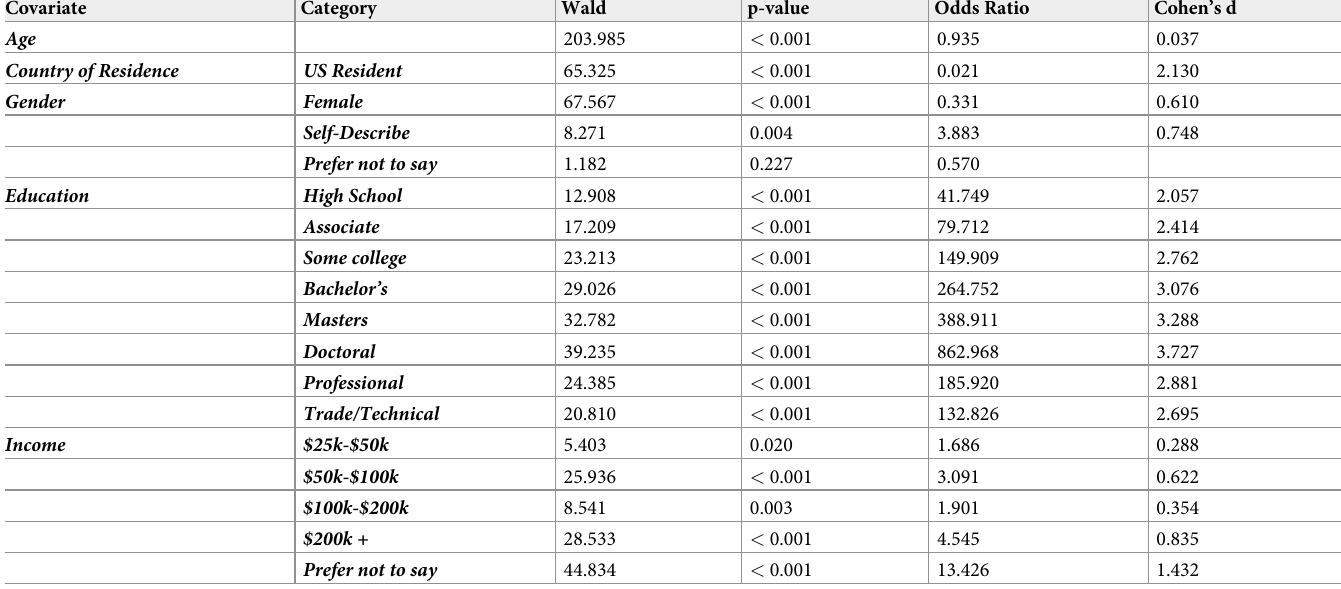
Table 5. Odds of challenge volunteer membership by gender, age, education, country of residence and income using logistic regression model, adjusted for HEX- ACO dimensions. Covariate